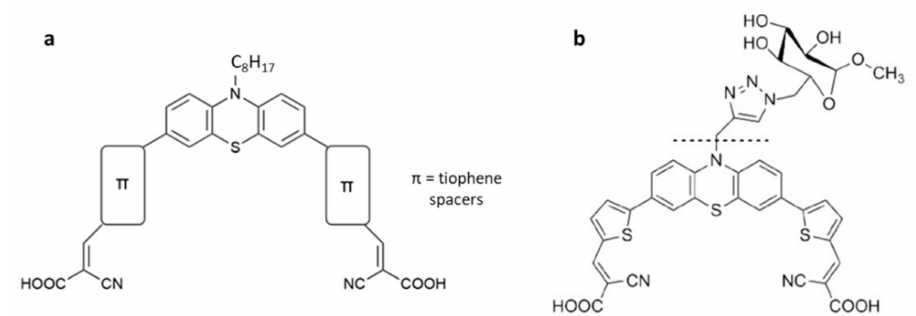
Figure 5. Structure of donor-acceptor dyes with phenothiazine as electron donor, functionalized with an alkyl chain ( a ) or a glucose derivative ( b ), thiophene spacers, and cyanoacrylic acid-based acceptor-anchoring groups. Adapted and reprinted with permissions from [58], Copyright (2015) Wiley and [59], Copyright (2018) American Chemical Society